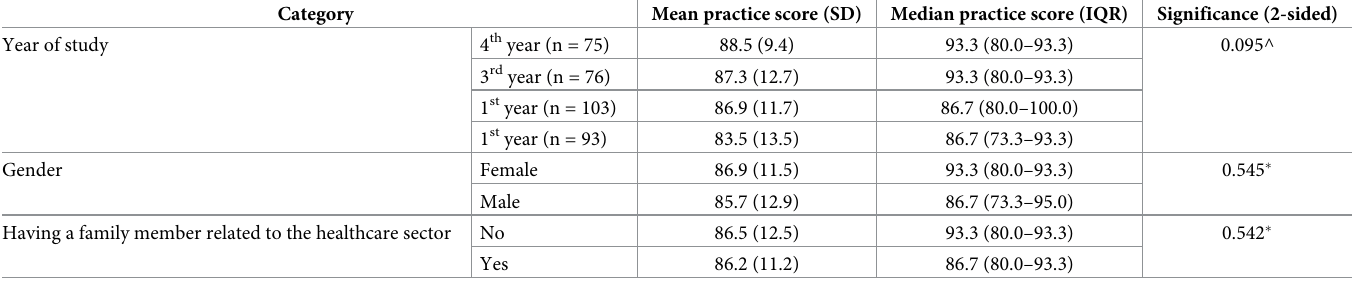
Table 2. Distribution of practice score according to the batches, gender and having a family member related to the healthcare